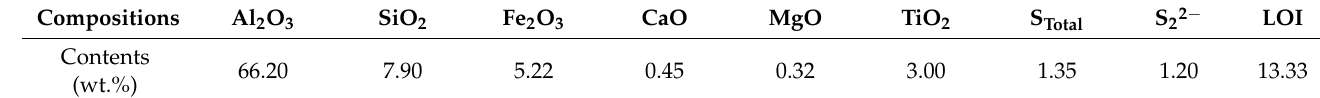
Table 1. Chemical composition and loss on ignition of high ‐ sulfur bauxite.